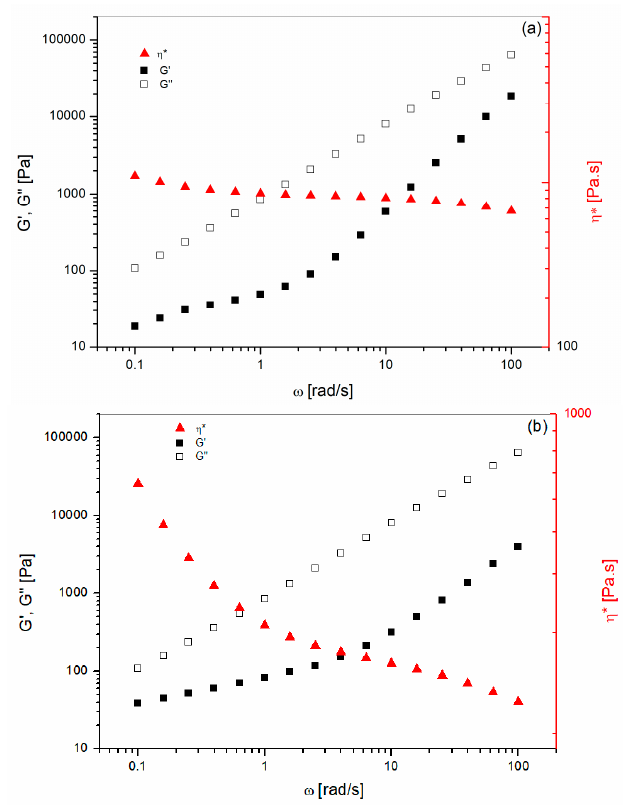
Figure 1. Isothermal rheology at 350 °C for: ( a ) PEI; ( b ) Ultem 9085.